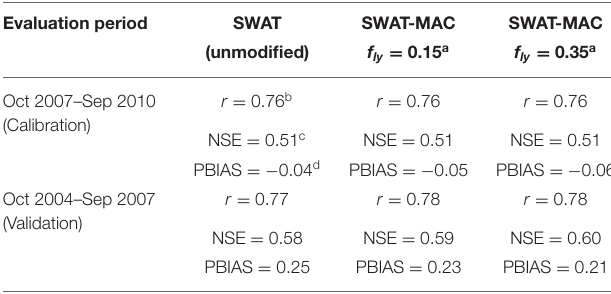
TABLE 3 | Goodness-of-fit statistics for streamflow from the Ewing subwatershed of the Pike River watershed, southern Quebec, Canada. Evaluation period